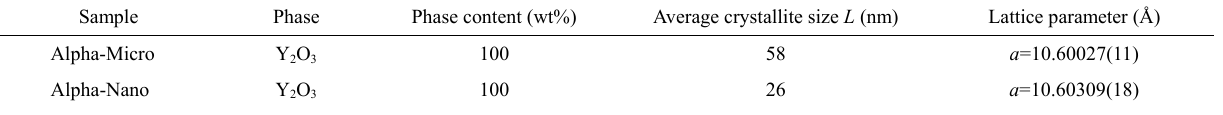
Fig. 2 X-ray diffraction patterns of Alpha-Micro (a), Alpha-Nano (b), and ITO-V (c) commercial Y 2 O 3 powders. Table 1 Phase composition of the starting Y 2 O 3 powders